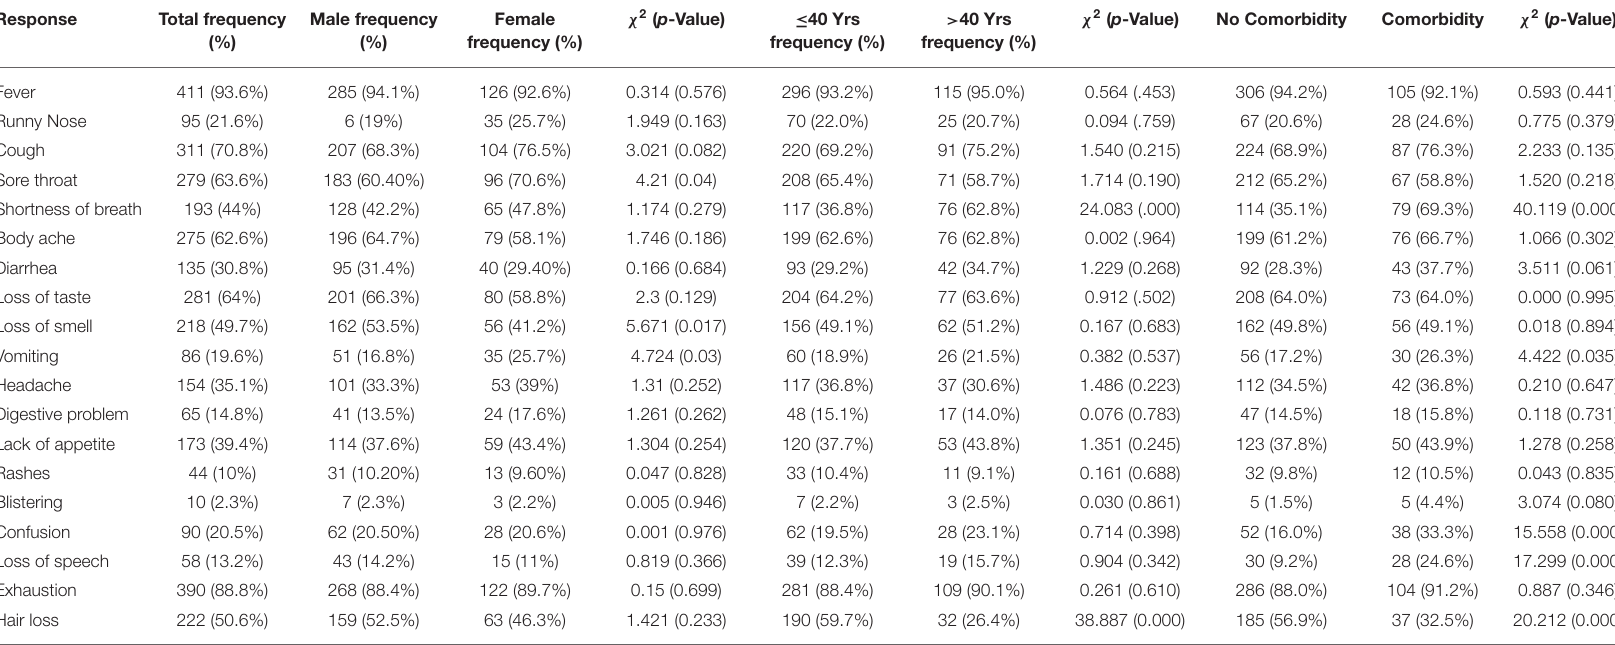
TABLE 3 | Prevalence of the Covid-19 associated symptoms among the participants, Bangladesh,